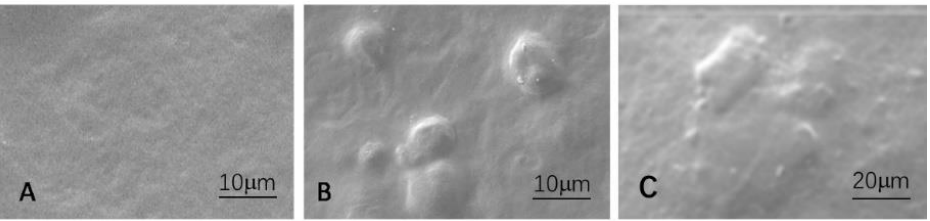
Figure 3. The surface images using SEM. ( A ) The pure starch film, ( B ) film containing cellulose crystals, ( C ) film with the laver.